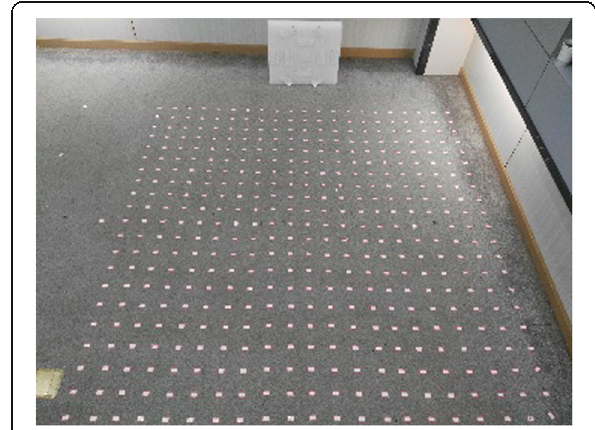
Fig. 10 RFID fingerprint map. RFID grid provides a reference point for tags ’ RSS signal